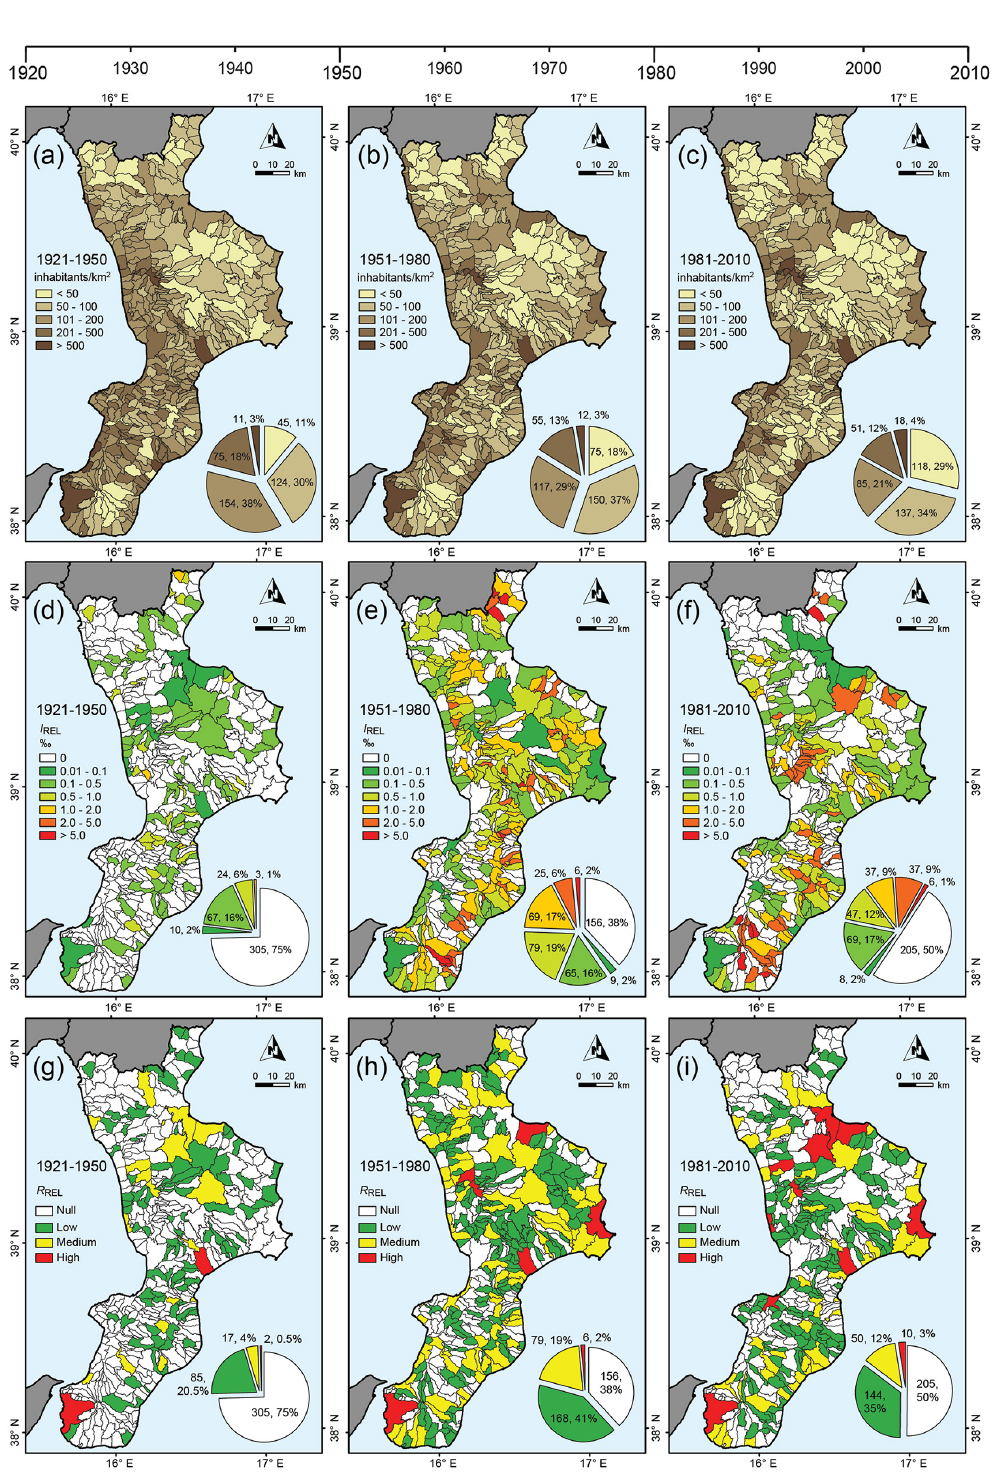
Figure 8. Top: Maps show density of population in the 409 municipalities in Calabria for three 30-year periods, (a) 1921–1950, (b) 1951– 1980, and (c) 1981–2010. Middle: Maps show landslide impact I REL given by the number of rainfall events with landslides (#REL) per 1000 people in each municipality in Calabria, for the (d) 1921–1950, (e) 1951–1980, and (f) 1981–2010 periods. Bottom: Maps show risk of rainfall events with landslides R REL , given by the product of the number of rainfall events with landslides (#REL) and of inhabitants in each municipality in Calabria, for the (g) 1921–1950, (h) 1951–1980, and (i) 1981–2010 periods. Key: Null, R REL = 0; Low, 0 <R REL ≤ 10000; Medium, 10000< R REL ≤ 100000; High, R REL > 100000. Pie charts show number and percentage of municipalities in each